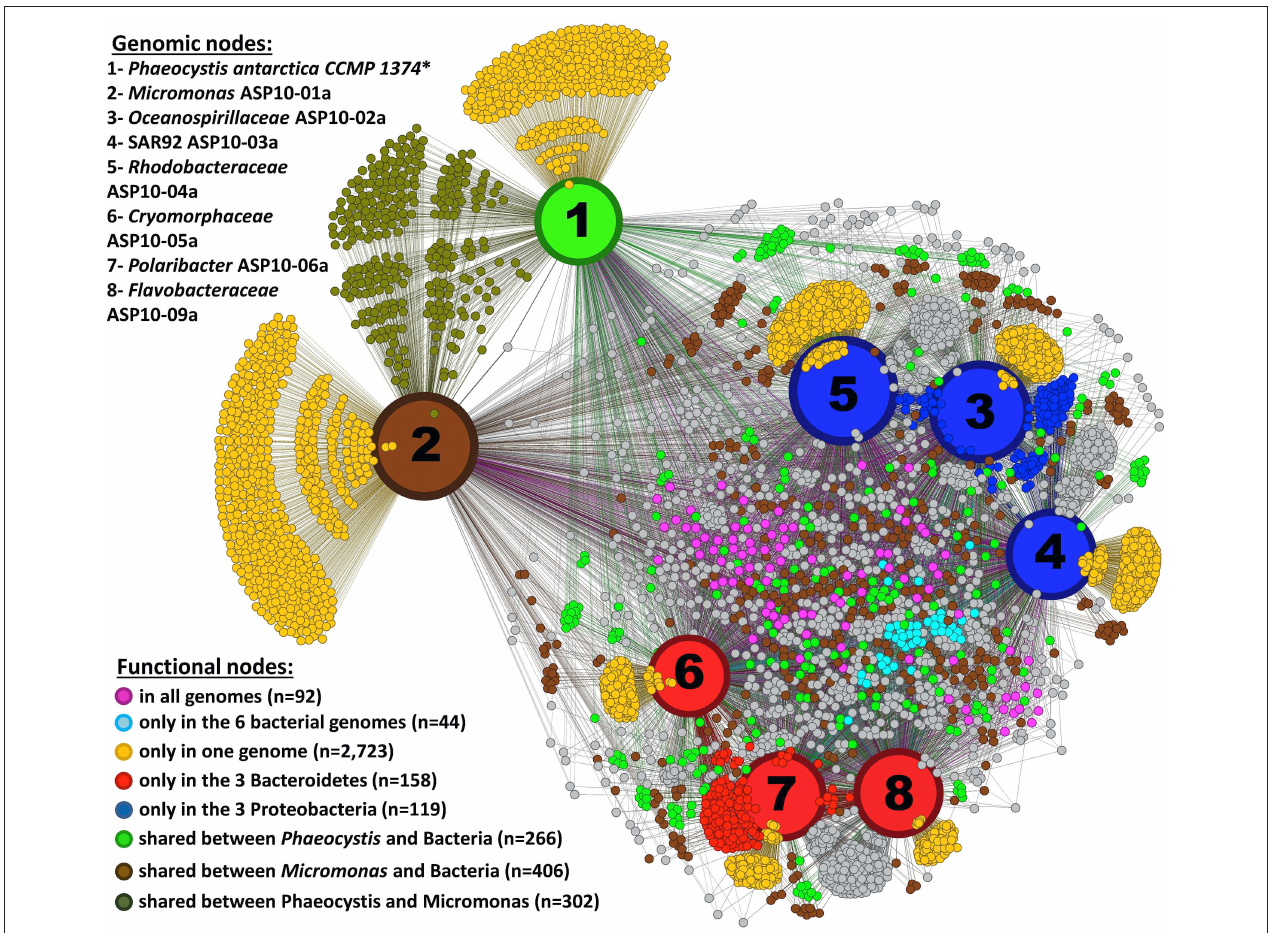
FIGURE 4 | Network connecting seven draft genomes recovered from the ASP plus the transcriptome of Phaeocystis antarctica strain CCMP 1374 ( * based on 33,153 contigs screened from the assembly of 99,805,691 HiSeq and 2,492,614 pyrosequencing RNA-seq reads) and their annotated functions from RAST (Aziz et al., 2008) (a total of 5590 functions). The network was performed using Gephi (Bastian et al., 2009) and Force Atlas